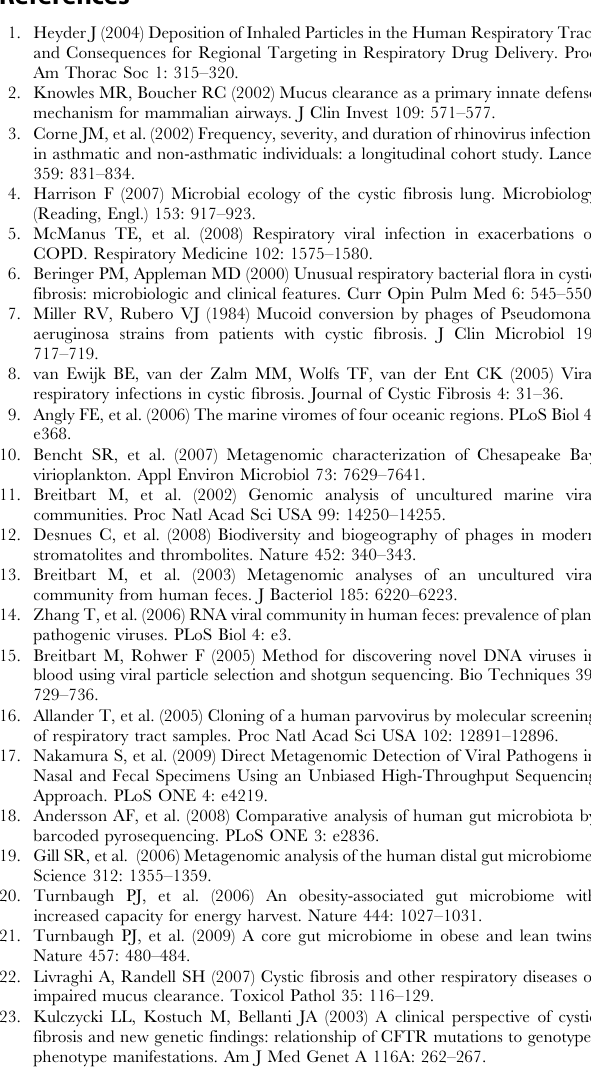
Figure S6 Virus-like Particles (VLPs) from the sputum sample of a CF patient. The VLPs were visualized by capture on a 0.02 m m Anodisc filter, SYBR Gold staining, and viewing under an epifluorescence microscope. The viruses appear as tiny bright pinpricks of light. Found at: doi:10.1371/journal.pone.0007370.s011 (0.26